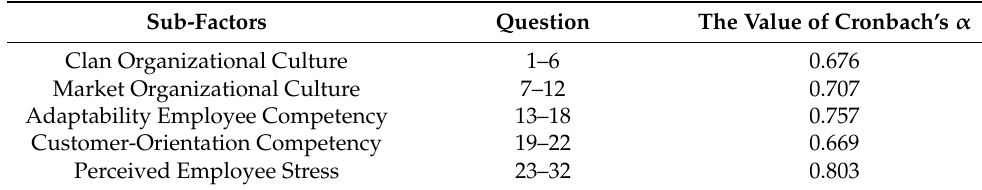
Table 7. The Statistical findings of reliability